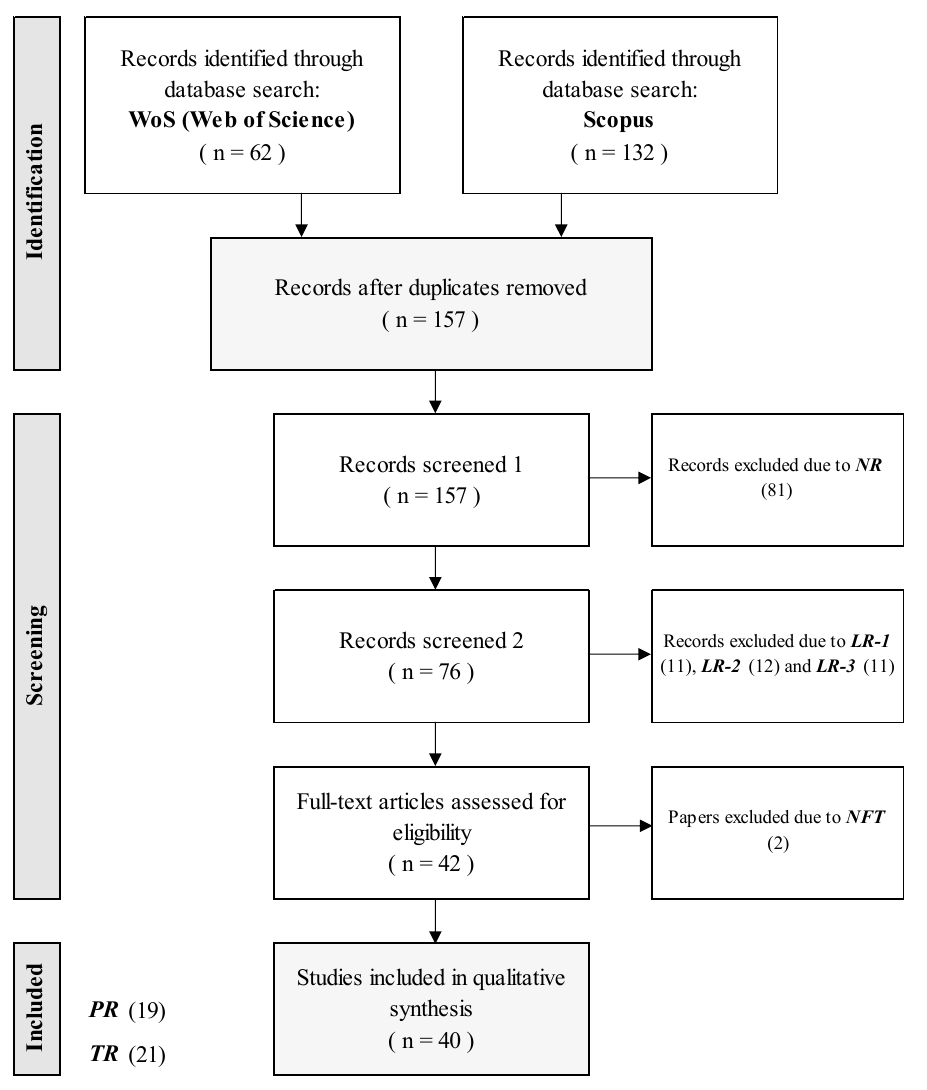
Figure 1. Search protocol (adapted from Page et al. McKenzie [33]). Table 1. Inclusion and exclusion criteria.